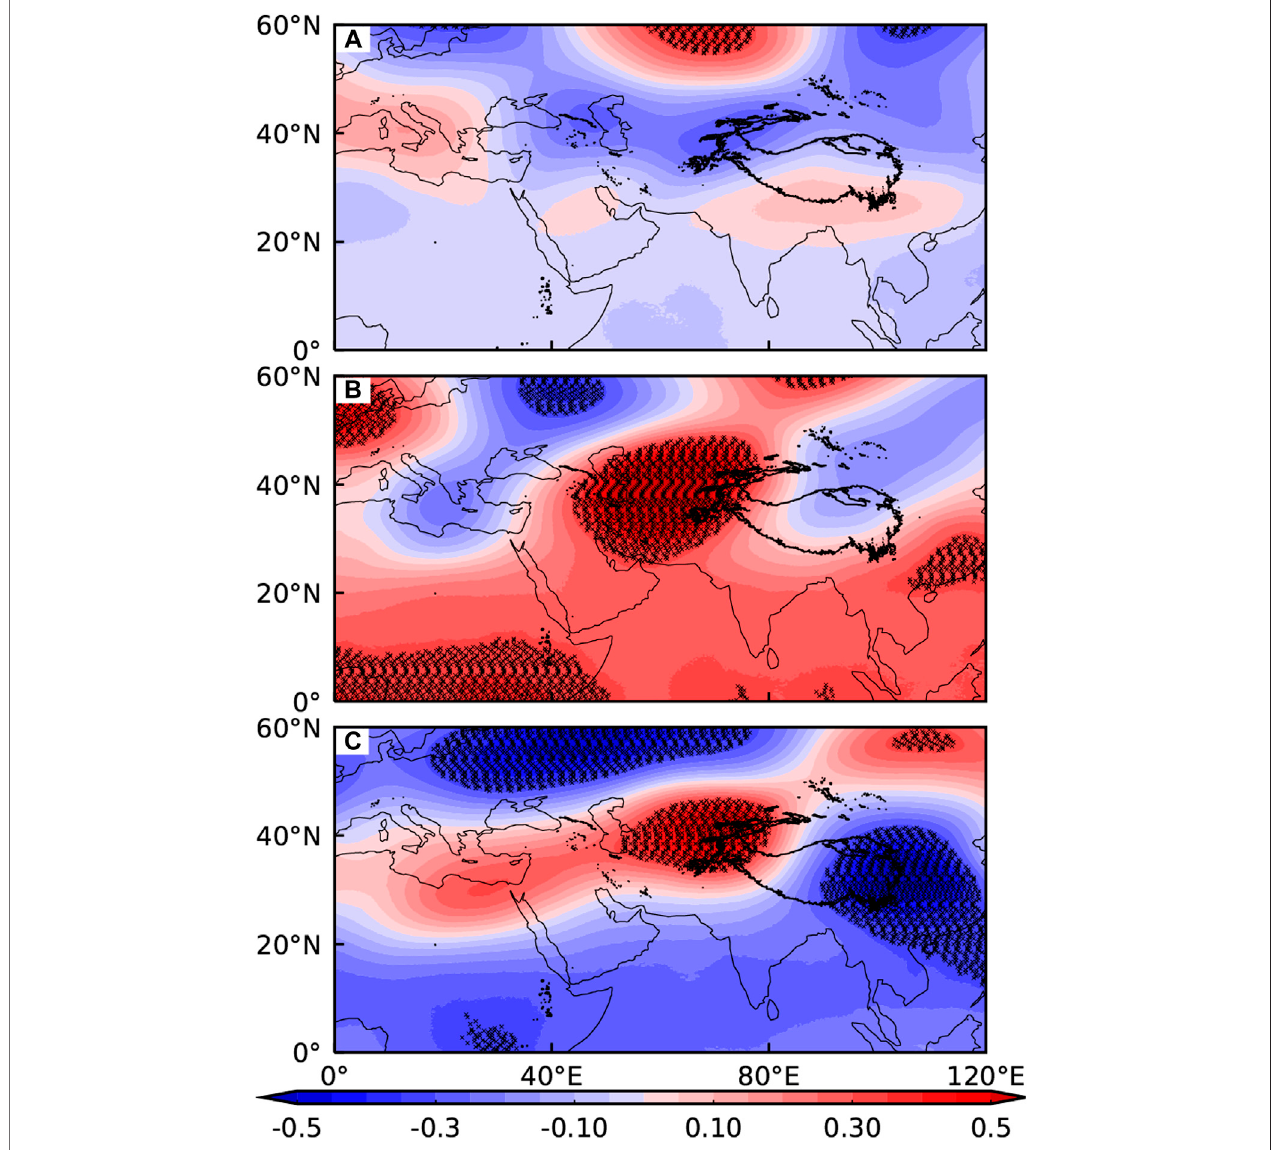
FIGURE 5 | Regression analysis of the 200 hPa geopotential height (shading, unit: km) against the time series of (A) EOF1, (B) EOF2, and (C) EOF3. Black dots represent the regressed 200 hPa geopotential height signi fi cant at the 95% con fi dence level.